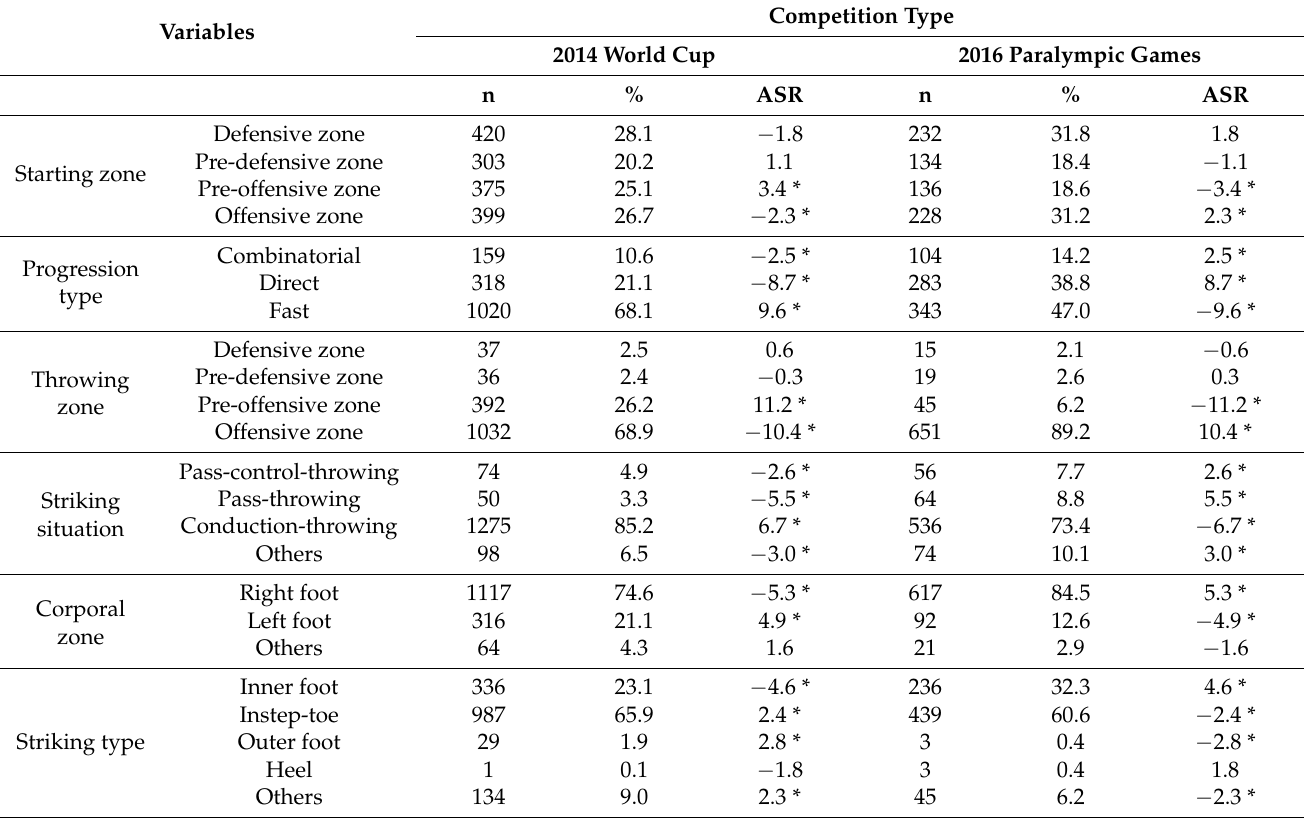
Table 4. Descriptive results and ASRs of the goal throwing variables in game of the Fa5